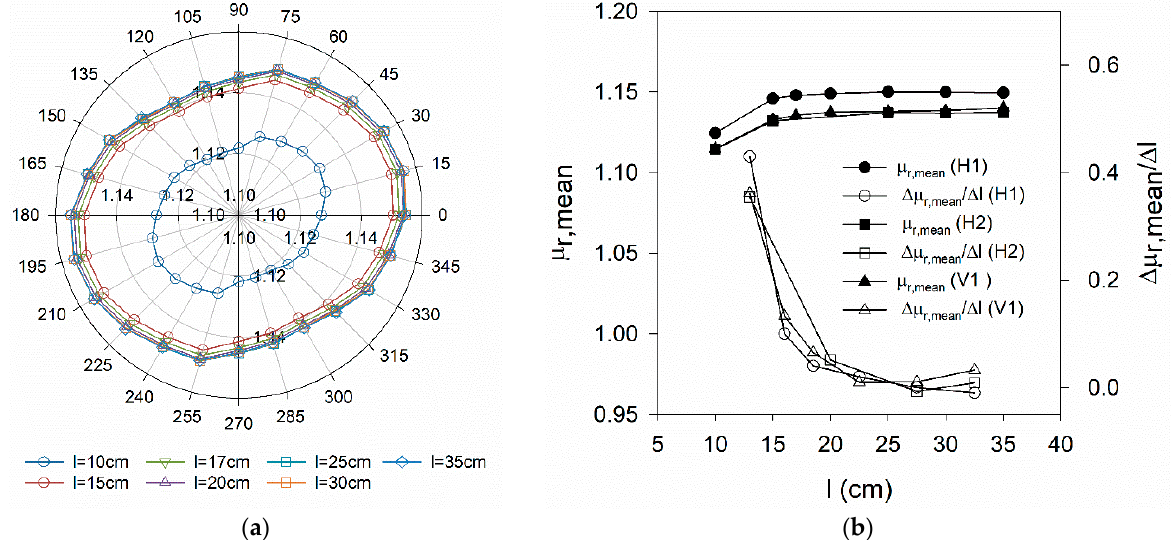
Figure 12. ( a ) Variation of µ r with the measuring direction (V f = 3%) for square specimens with varying size (plate H1) ; ( b ) Variation of µ r,mean with the specimen size l (plates H1, H2 and V1).